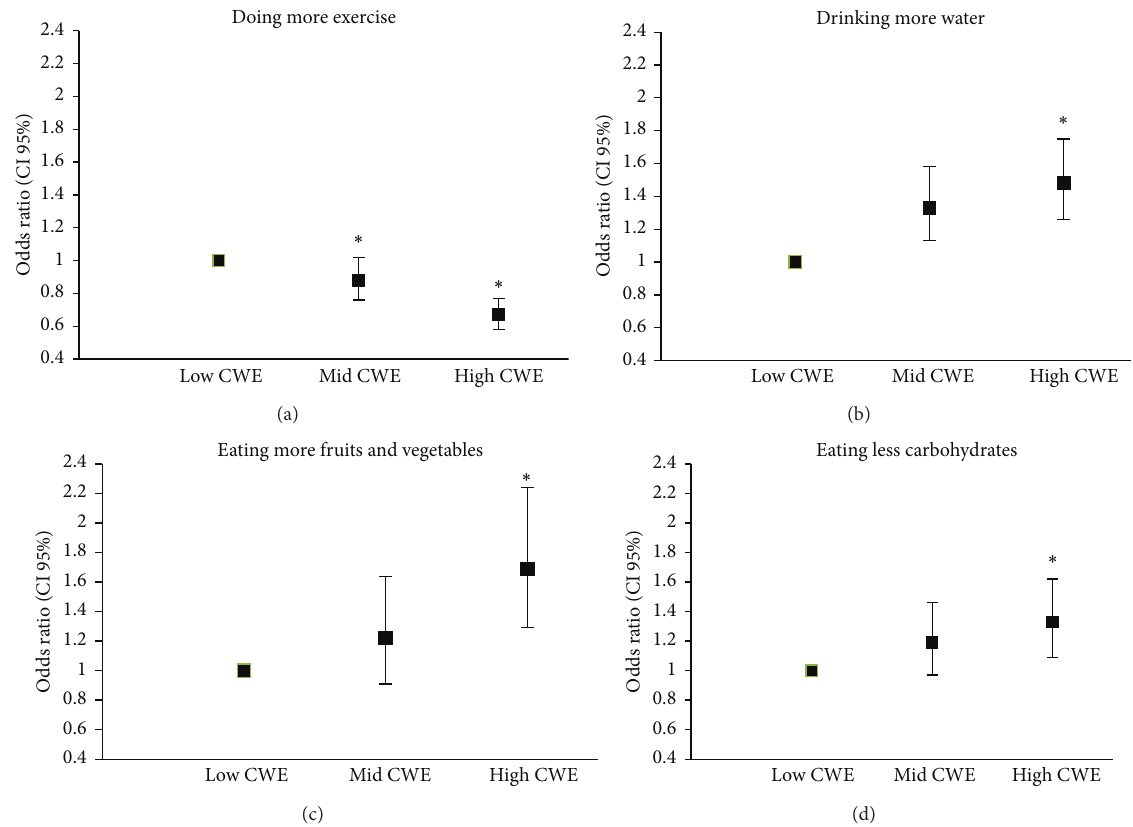
Figure 1: Strategies used to lose weight across CWE groups. ∗ Significantly different from the low CWE group.